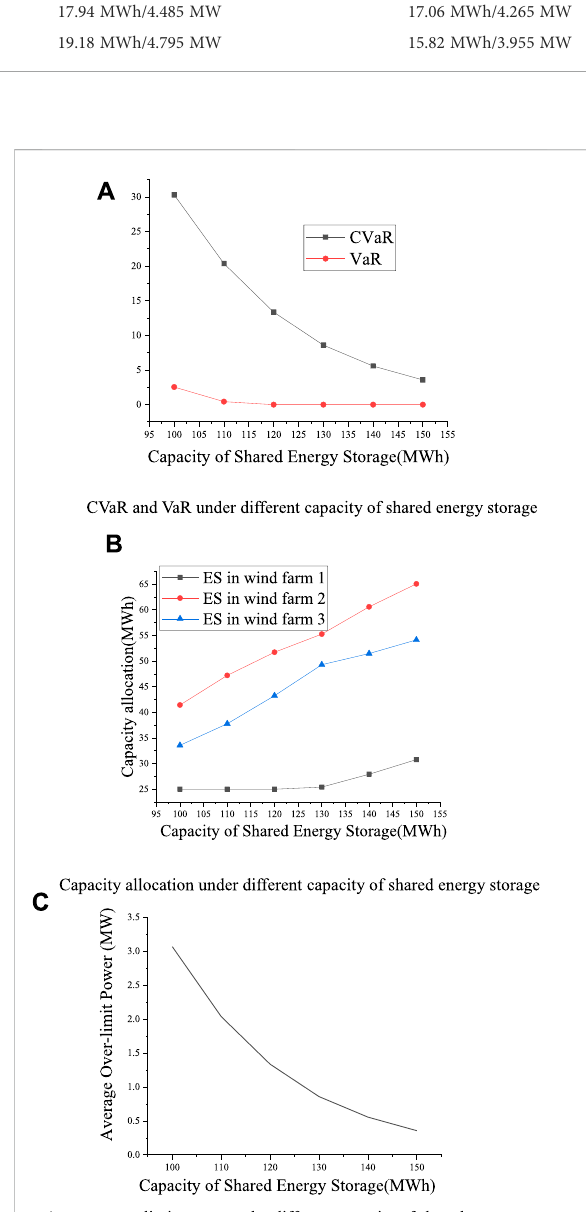
FIGURE 10 Solution results under different capacity of shared energy storage. (A) CVaR and VaR under different capacity of shared energy storage (B) Capacity allocation under different capacity of shared energy storage (C) Average over-limit power under different capacity of shared energy